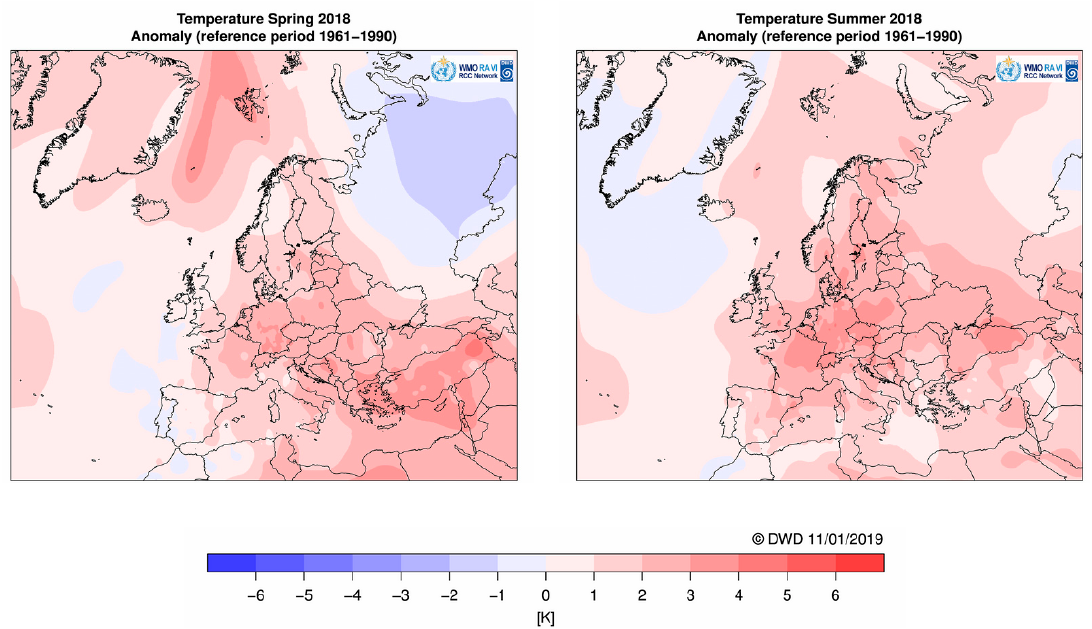
Figure 1. Deviation of the seasonal mean temperature in 2018 from the mean temperature of the reference period of 1961 to 1990, over Europe. Climate maps are provided by the German weather service, Deutscher Wetterdienst, (DWD) [23].